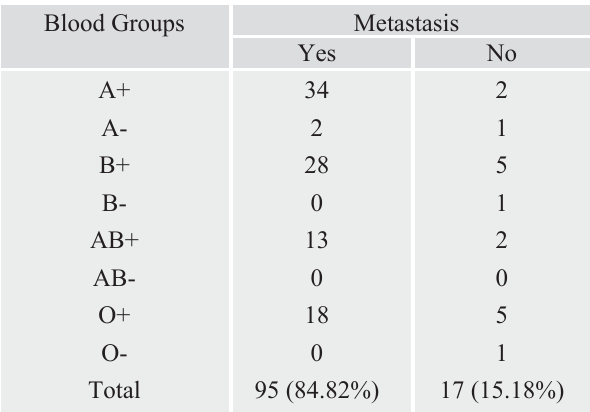
Table IV: Frequency of metastasis in breast